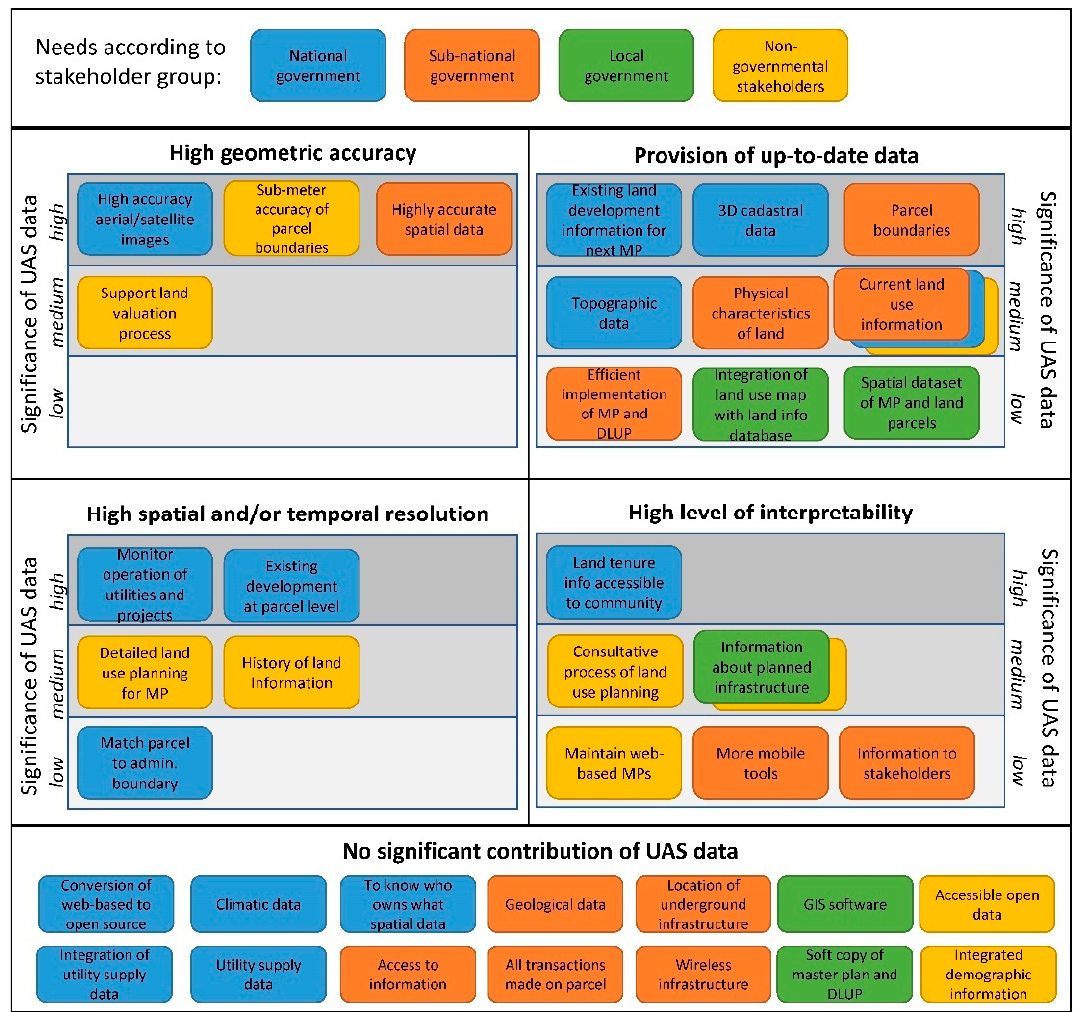
Figure 6. Prioritized needs classified by the ability of UAS data to match stated needs with further association to key characteristics of UAS data and ranking according to the significance of the